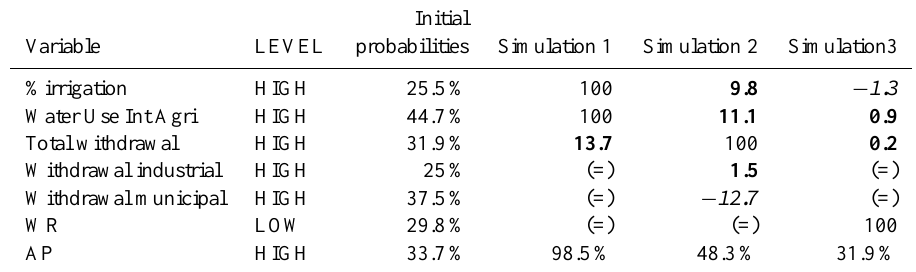
Table 6. Thematic model-AP simulations. In italic, negative variations and in bold, the positive variations of probabilities.